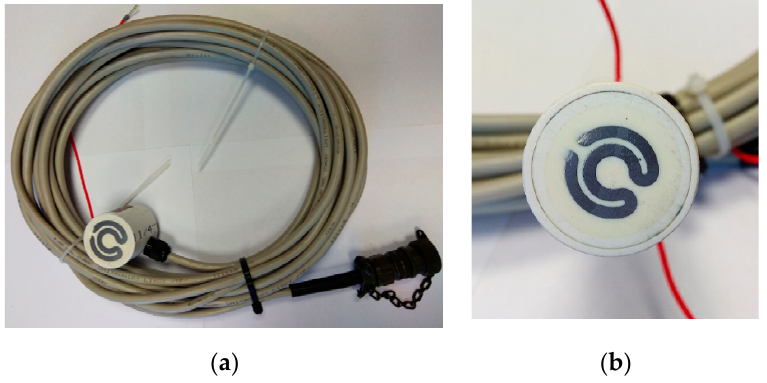
Figure 10. Corrosion sensor: (a) complete with a connecting cable, (b) view of a measuring ele- ment.